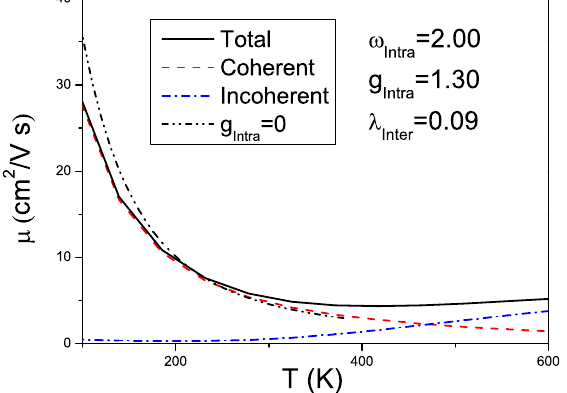
Figure 7. Mobility and its different contributions as a function of the temperature, T, at λ = 0 . 09 and g = 1 . 3 . We consider ω = 2 (in units of t , with t = 80 Inter Intra Intra